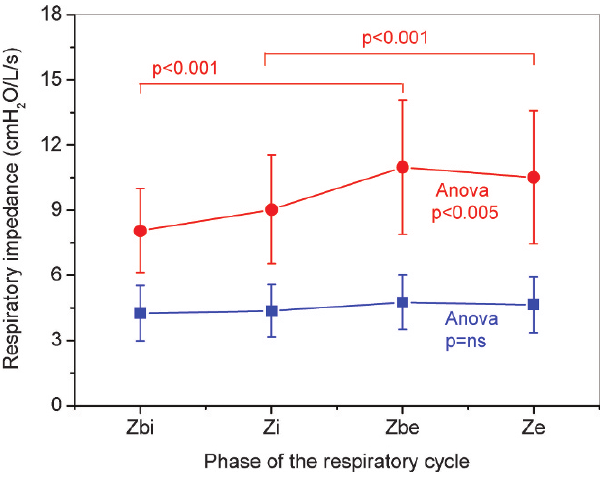
Figure 1 - Mean Zrs values during the ventilatory cycle in COPD (red lines) and healthy subjects (blue lines).